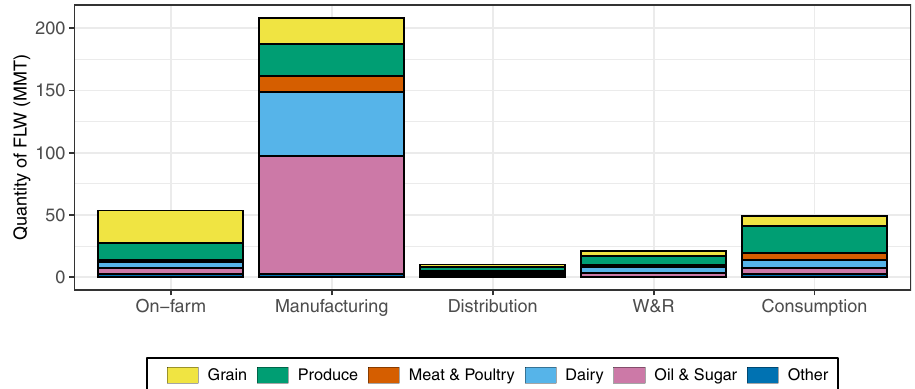
Fig. 3 FLW in the different stages of the FSC. Breakdown of FLW by commodity group for each FSC stage: on-farm (on-farm production), manufacturing (food manufacturing), distribution, wholesale and retail (W&R), and consumption. Commodities are grouped for visual clarity and remain in order from top to bottom of each column: grain (yellow), produce (fruits and vegetables, green), meat and poultry (vermillion), dairy (light blue), oil and sugar (purple- pink), other (dark blue) includes the low demand commodities — nuts, seafood, and